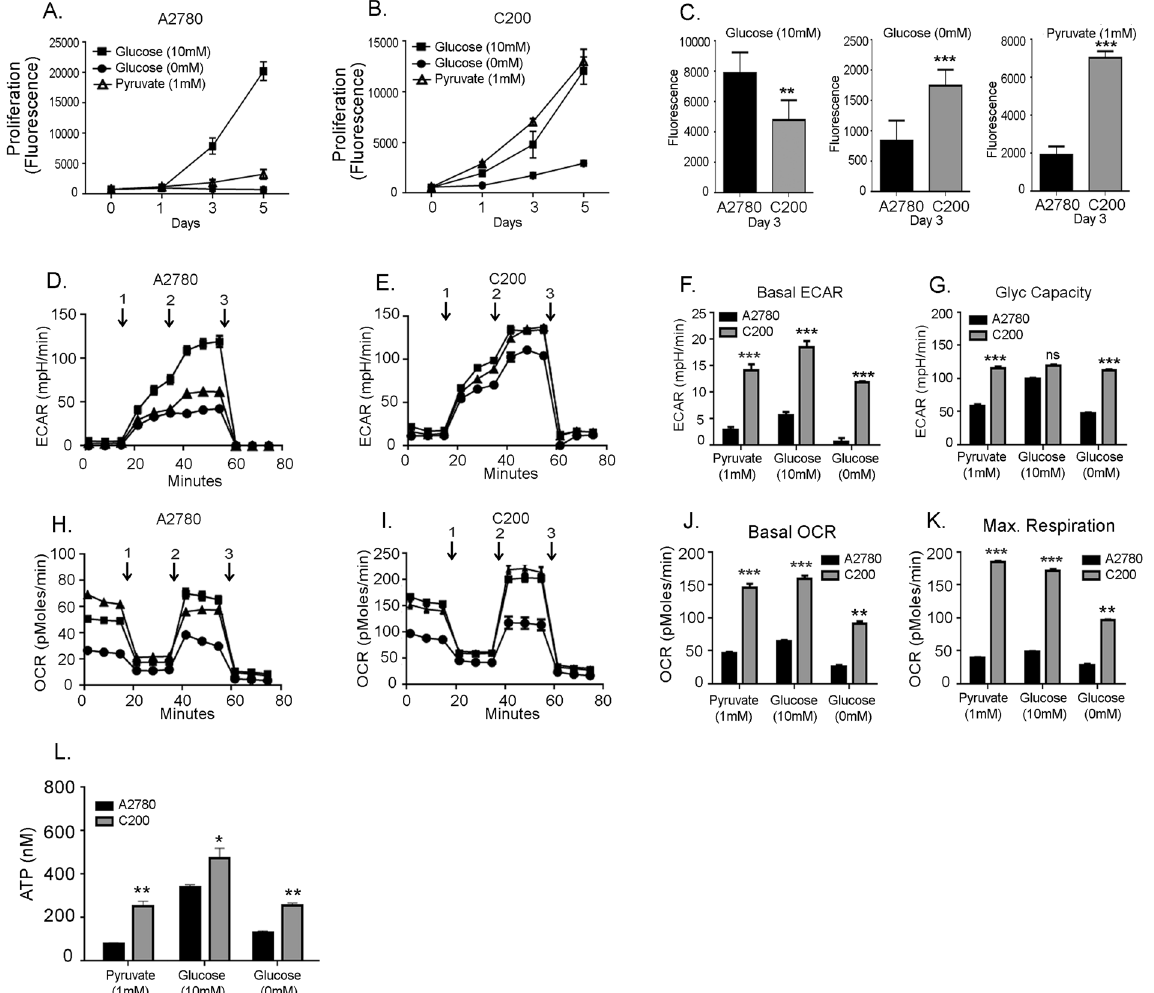
Figure 5. Chemosensitive ovarian cancer cells are more sensitive to glucose deprivation. ( A ) A2780 and ( B ) C200 cells were cultured in glucose free (0mM glucose) Roswell Park Memorial Institute 1640 media containing 5% dialyzed fetal bovine serum or supplemented with 10 mM glucose or 1 mM pyruvate. Proliferation of cells was measured using CYQUANT ® NF cell Proliferation Assay by measuring fluorescence intensity at different time points as indicated. ( C ) Bar graph representation of the cell proliferation under various conditions at day 3. The experiment was performed in triplicates and repeated twice. *** p < 0.001, ** p < 0.01 C200 compared to A2780. Under similar conditions, at 48 h, an equal number of cells were plated in multi-well Seahorse Biosciences XF96 plate (Boston, MA) for measurement of ECAR ( D , E ) and OCR ( H , I ). For ECAR, injections 1, 2, 3 represents glucose, oligomycin and 2DG respectively. For OCR, injections 1,2,3 represent oligomycin, FCCP and rotenone respectively. Basal ECAR ( F ), glycolytic capacity ( G ), basal OCR ( J ) and maximum respiration ( K ) were calculated as described in the Materials and Methods and are represented as bar graphs. The experiment was performed in triplicates and repeated twice. *** p < 0.001, ** p < 0.01 C200 compared to A2780. ( I ) Under similar conditions ATP production was measured by a Biovision fluorescence assay kit. *** p < 0.001, ** p < 0.01, C200 compared to